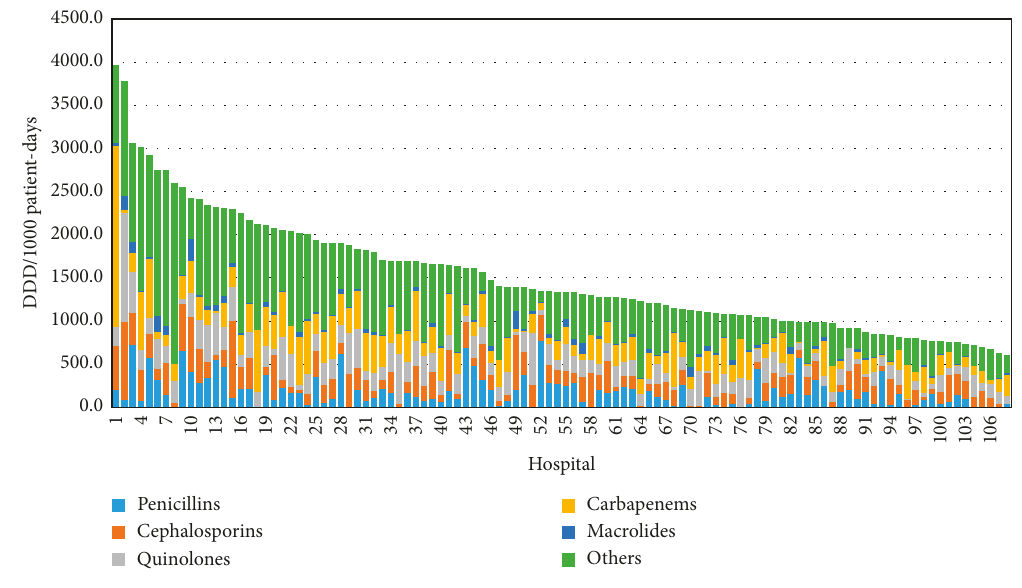
Figure 4: Antibiotic classes used in each of the 108 ICUs participating in the study. ICUs are presented on the X -axis in the order of decreasing antibiotic